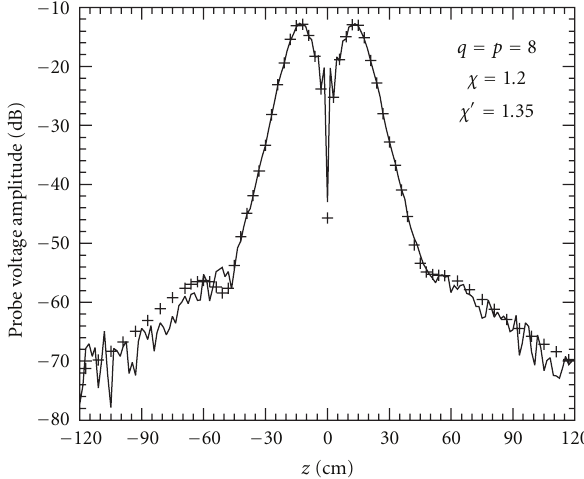
Figure 9: Amplitude of the probe output voltage V on the generatrix at ϕ = 90 ◦ . Solid line: exact. Crosses: reconstructed from error a ff ected data.